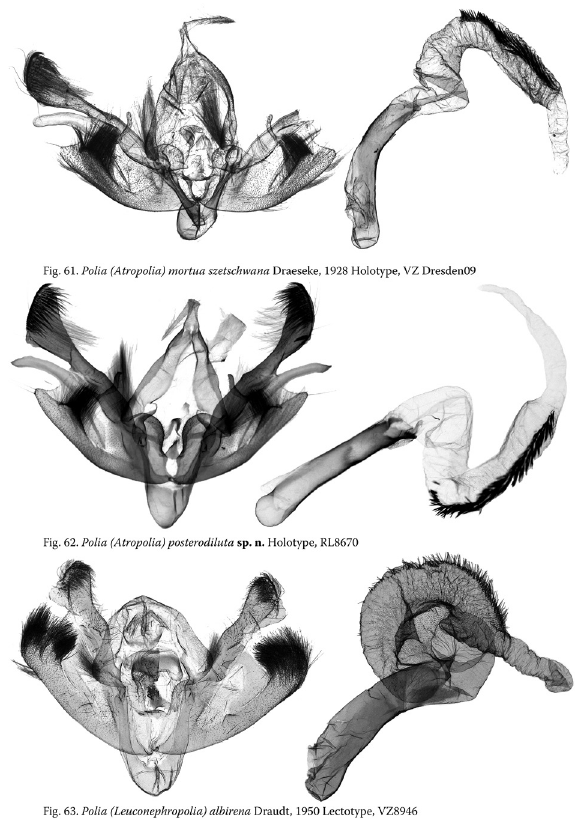
Figure 64–66. 64. Polia ( Polia ) atrax Draudt, 1950 Lectotype male. 65. Polia ( Polia ) griseifusa Draudt, 1950. 66. Polia ( Po- lia ) lama lama (Staudinger, 1896) Holotype